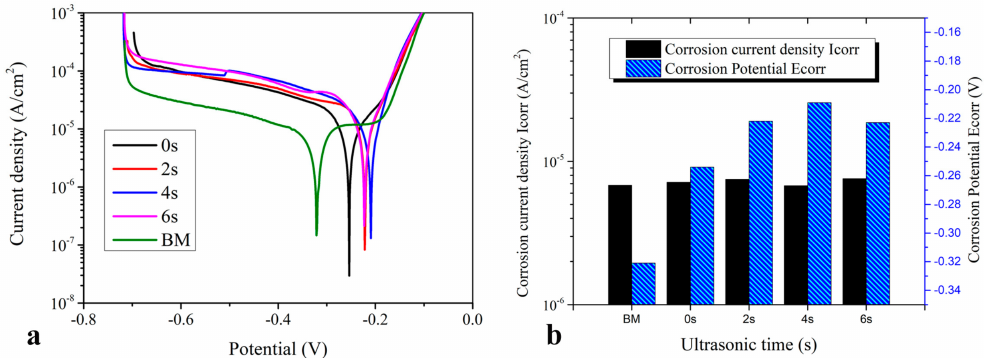
Figure 16. Corrosion resistance of the copper weld joint; ( a ) potentiodynamic polarization curves; and ( b ) corrosion current density and electric potential obtained by Tafel